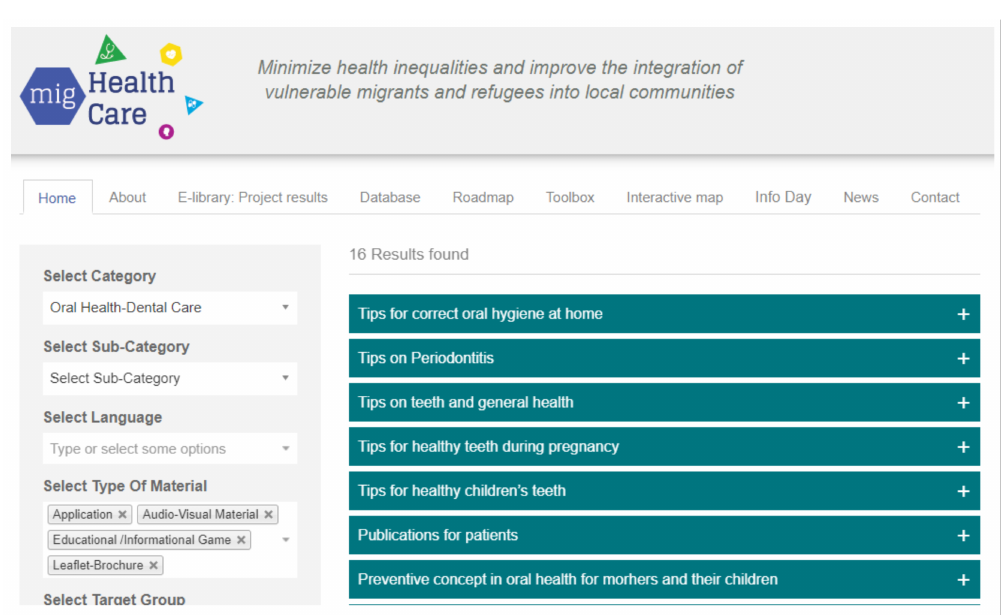
Figure 1. Screenshot of the tools and information regarding dental